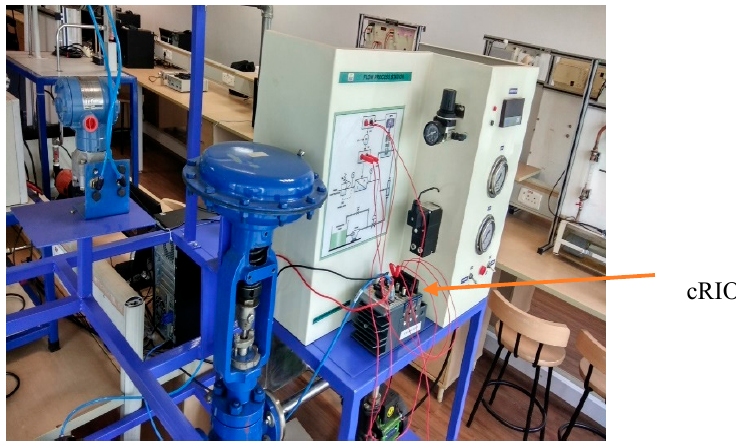
Figure 2. Piping and instrumentation diagram (P&ID) of flow process.